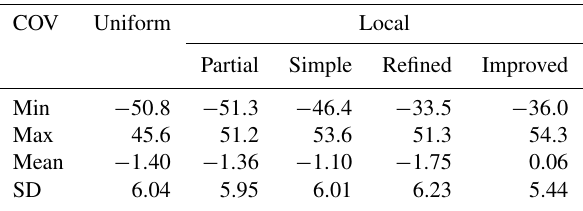
Table 11. Statistics of the different COV strategies over all the re- gions (mGal).